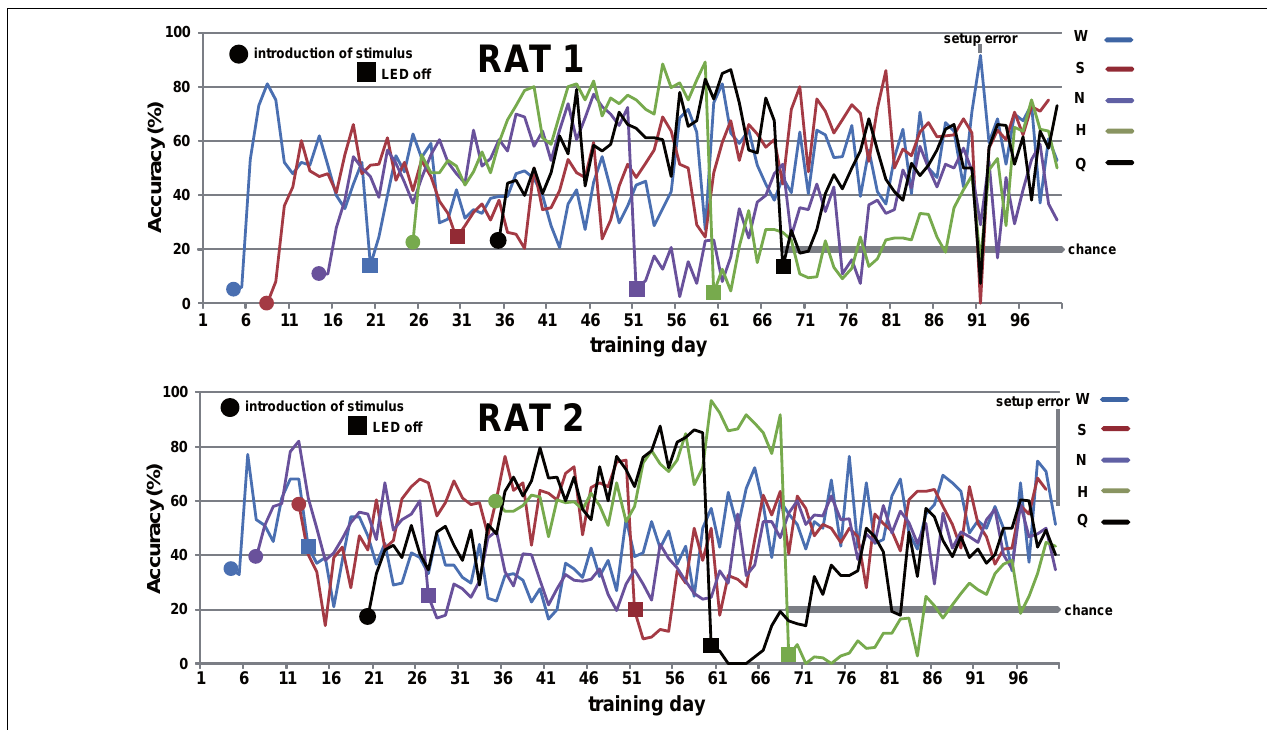
FIGUREA2 | First hundred days of training of rat 1 (top) and 2 (bottom). Stimuli were sequentially added and spout choice guided by LED light. Sequences were randomized across rats. LED cues were turned off in same sequence as stimuli were introduced. Chance performance is 20% when only taste cues